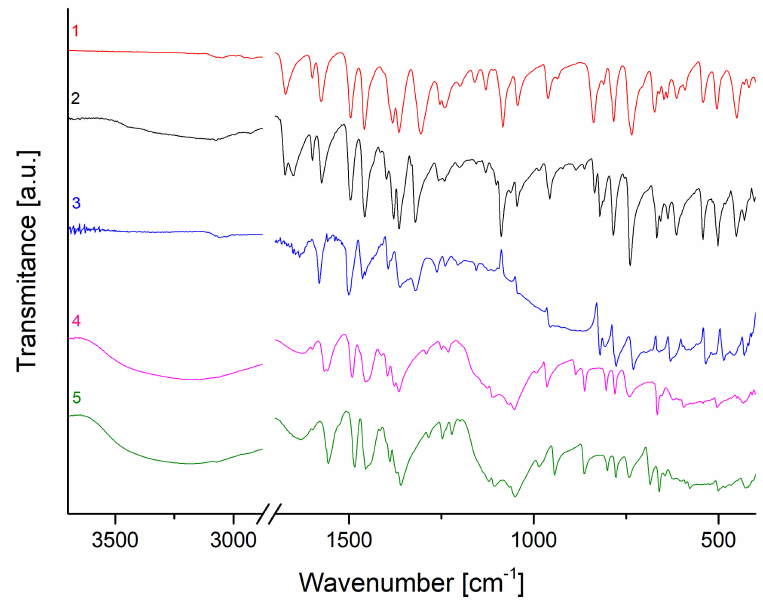
Figure 2. FT–IR spectra of 1 – 5